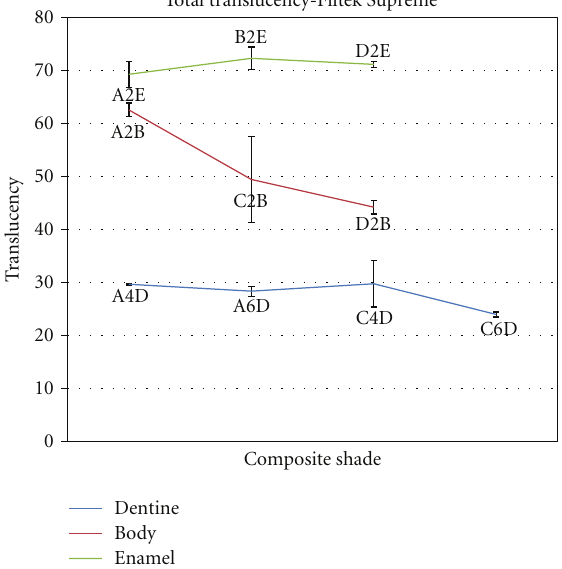
Figure 4: Mean total translucency for di ff erent shades of Filtek Supreme composite